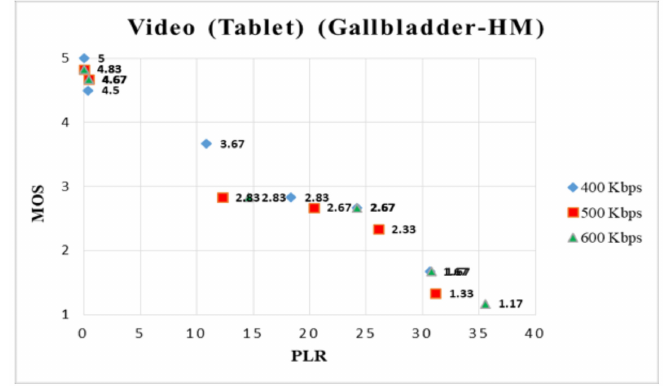
Figure 12. MOS ratings for gallbladder ultrasound (HM) on tablet.